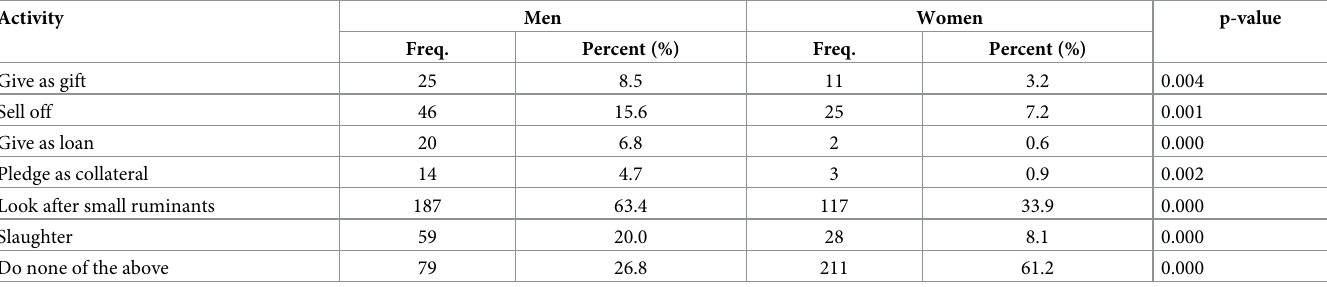
Key: Freq. = frequency, Percent = percentage. Number and proportion of men and women respondents that reported their spouses could undertake the activities out of those that responded to the